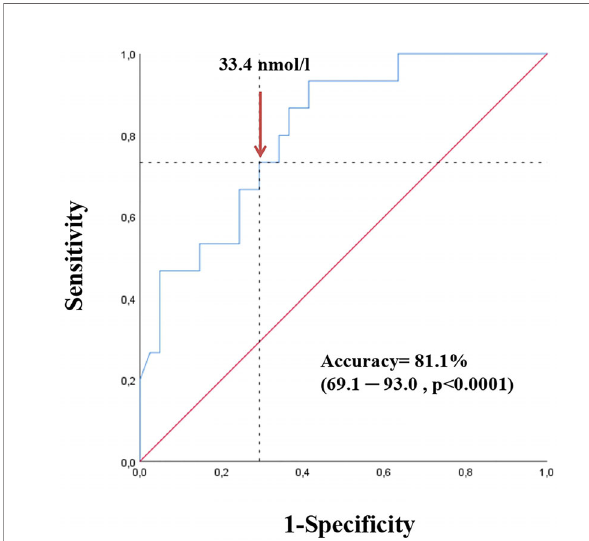
FIGURE 1 | Receiver operating characteristic (ROC) curve for SHBG in detecting NAFLD risk according to NAFLD-LFS (values > -0.640 predict NAFLD with sensitivity of 86% and speci fi city of 71 %) in the fi rst cohort.